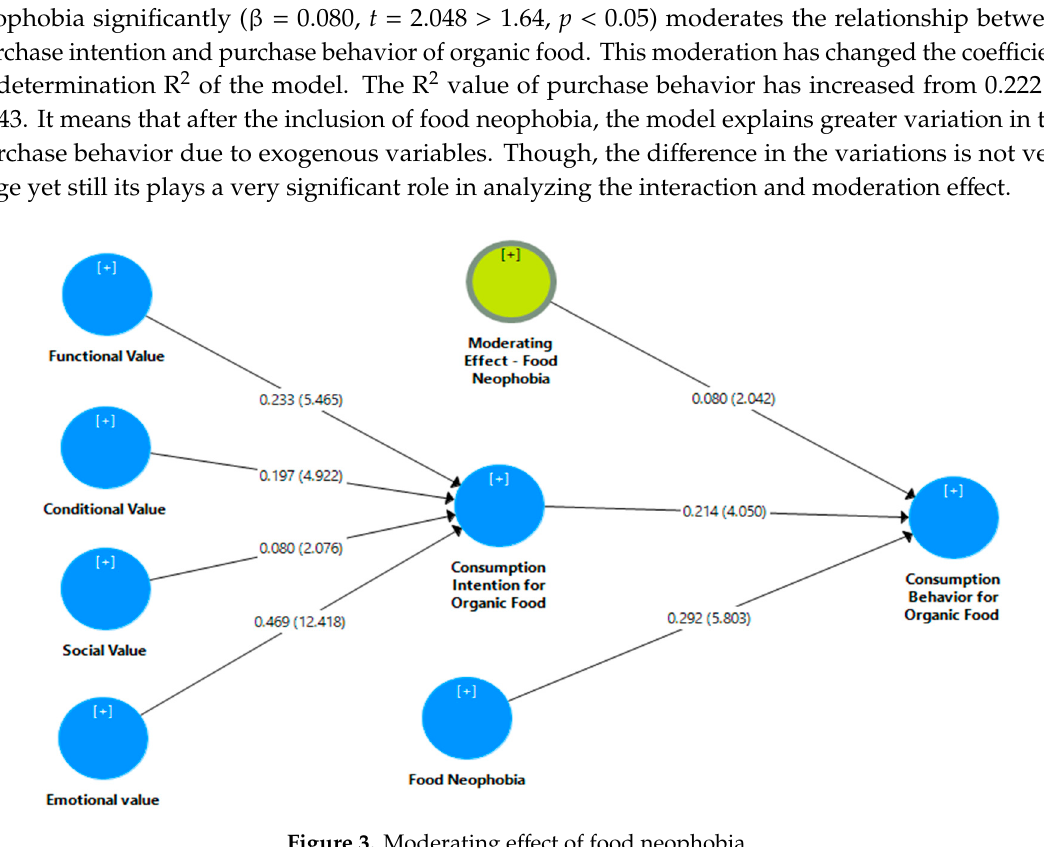
Figure 3. Moderating effect of food neophobia